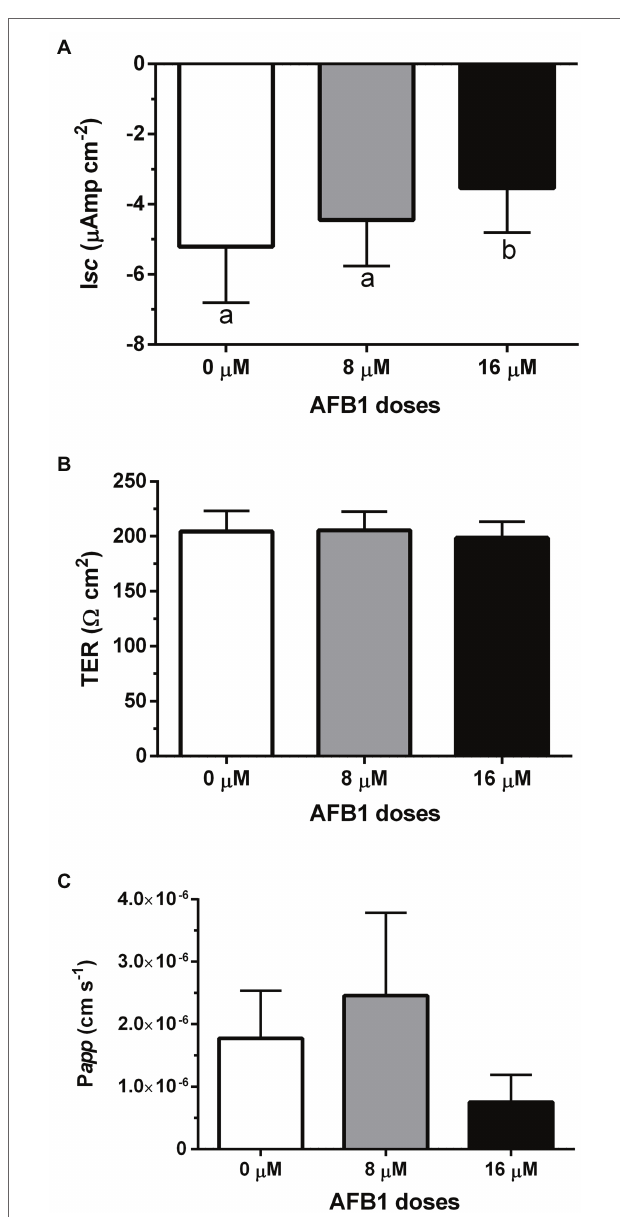
FIGURE 2 | I sc (A) , TER (B) , and P app (C) in response to increasing concentrations of luminal AFB1 (8 and 16 μ M) in the anterior intestine of control S. aurata individuals mounted in Ussing chambers. Data are presented as mean ± SEM (n = 6; p < 0.05, matched-measures one-way ANOVA followed by Tukey’s post hoc